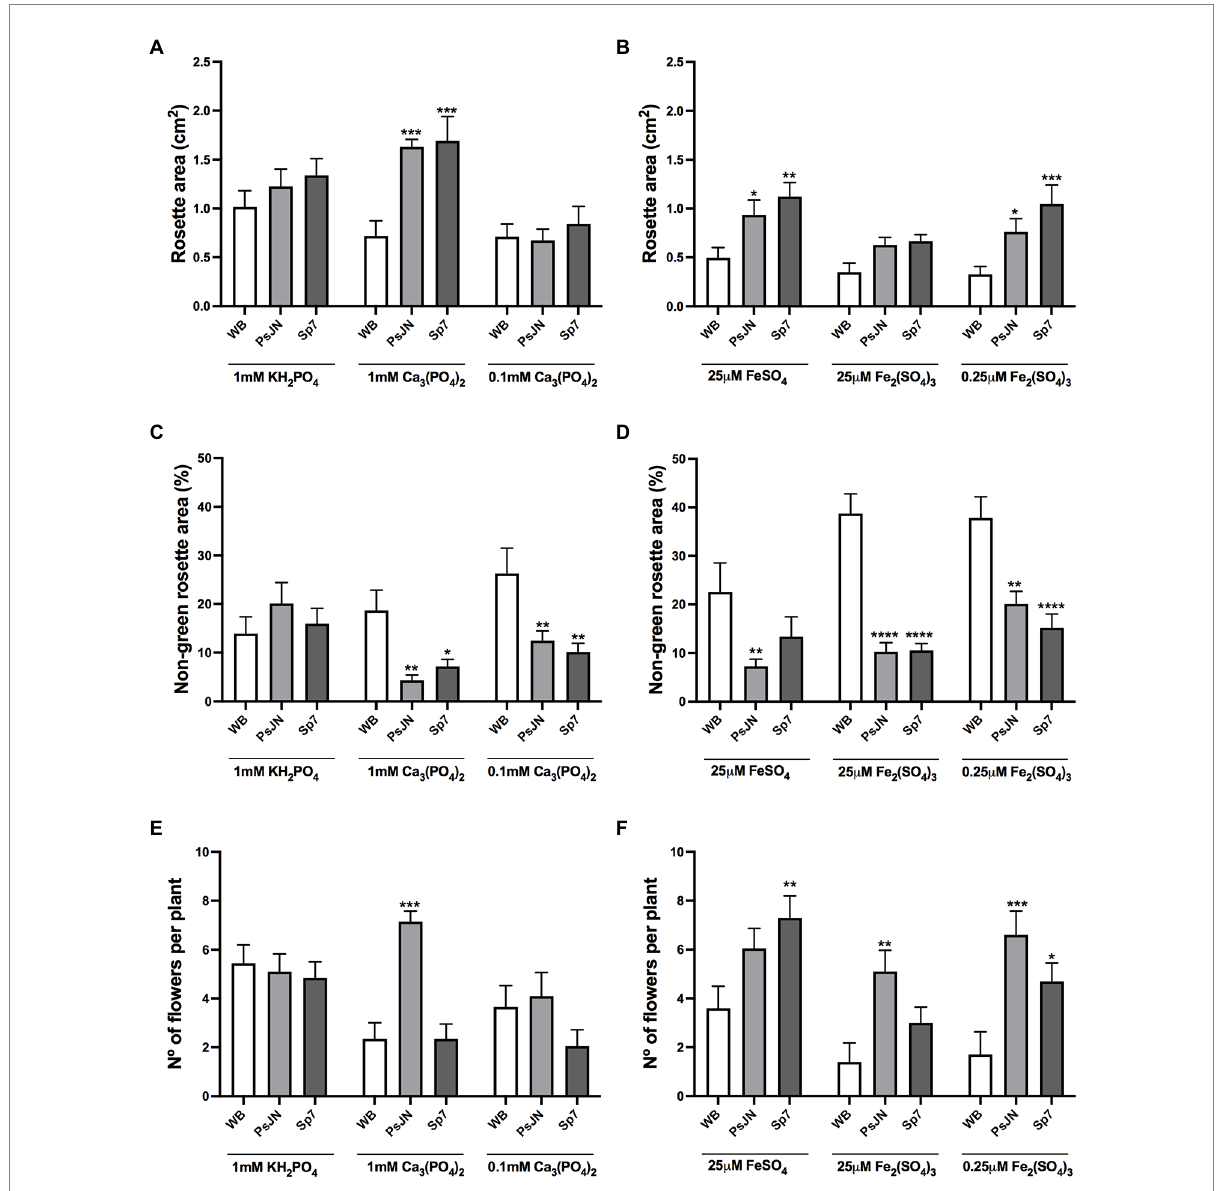
FIGURE 4 Long-term effects of different sources of phosphorus and iron in plant growth and flowering in Arabidopsis thaliana inoculated with beneficial rhizobacteria. Rosette area (A,B) , non-green rosette area (C,D) , and the number of flowers per plant (E,F) in plants 34 days after sowing. Factor 1 consisted of different concentrations of KH 2 PO 4 /Ca 3 PO 4 (as phosphate sources with different solubilities; A,C,E ) or FeSO 4 /Fe 2 (SO 4 ) 3 (as iron sources with different solubilities; B,D,F ). Factor 2 consisted of non-inoculated plants (WB) or inoculated with Paraburkholderia phytofirmans PsJN (PsJN) or Azospirillum brasilense Sp7 (Sp7). Data are means ± SE of 20 replicates per treatment. Asterisks indicate significant differences between each treatment and their respective WB treatment (Two-way ANOVA and Tukey multiple comparisons, * p < 0.05; ** p < 0.01; *** p < 0.001, and **** p <